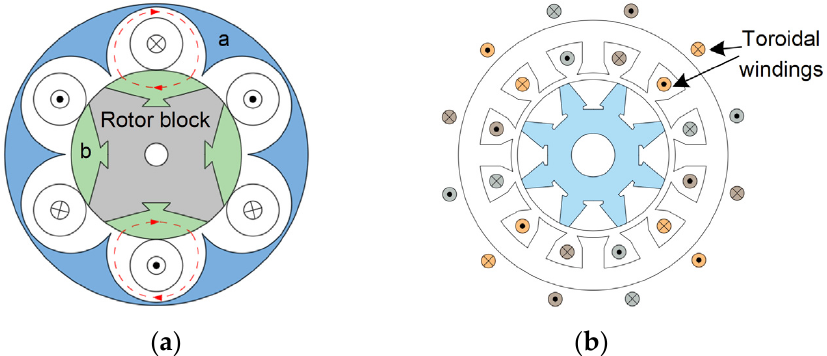
Figure 5. Proposed improvement measures for segmental rotor SRM. ( a ) is the circle stator slot topology for 6/4 segmental rotor SRM where “a” is the stator sleeve and “b” is the segmental rotors; ( b ) is the proposed toroidal winding connection.